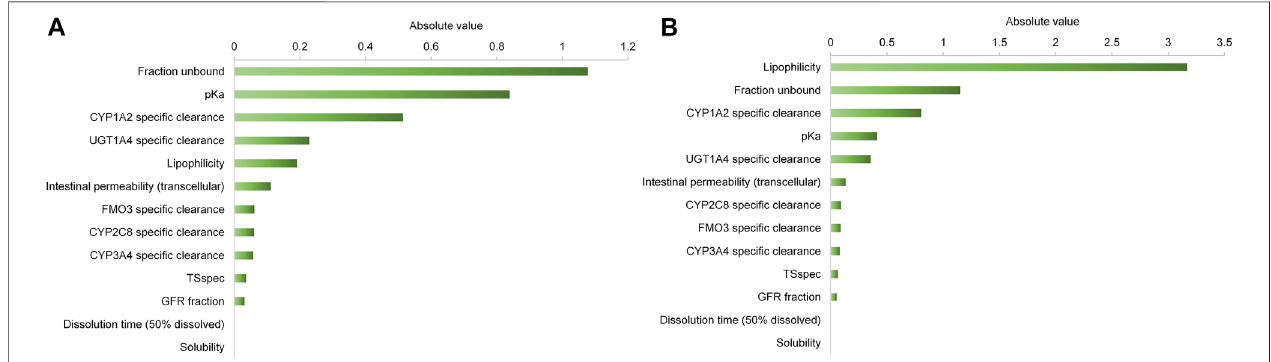
TABLE 3 | Simulated and observed pharmacokinetic parameters of olanzapine from model development. — Single dose Co-administered with Simulated